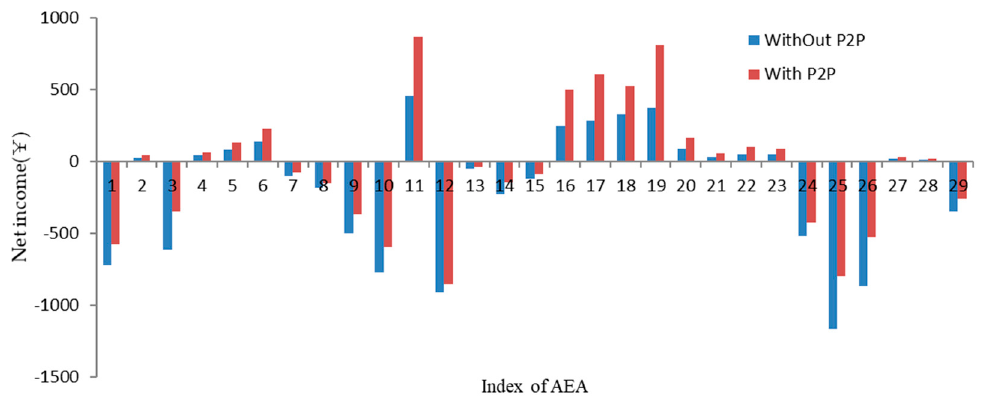
Figure 10. Advantage of P2P transaction on net income of AEAs.